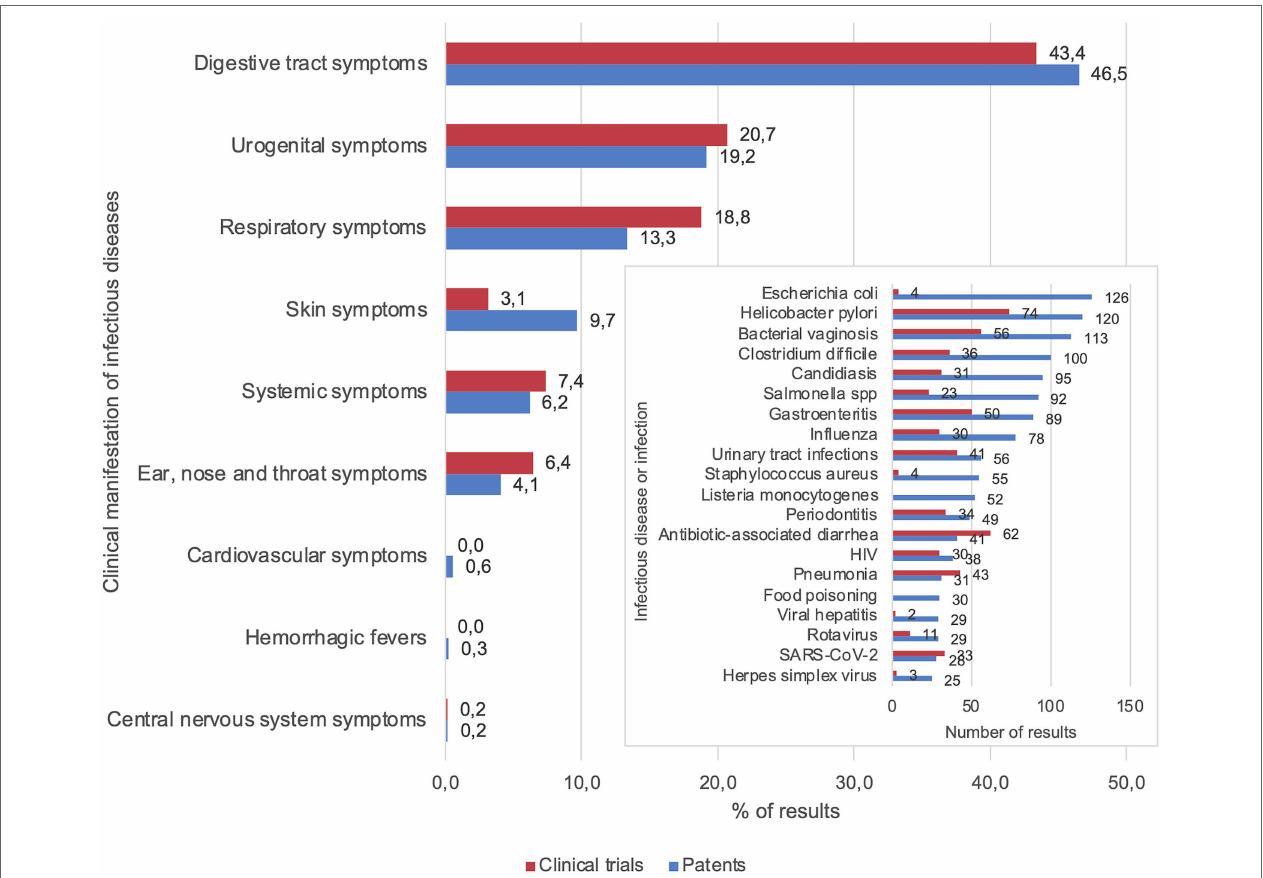
FIGURE 2 | Focal points of patents and clinical trials were digestive tract, urogenital, and respiratory symptoms. Percentages of patent and clinical trial results for each category of infectious diseases based on clinical manifestation. The 20 infectious diseases that were mentioned most frequently in patents are displayed in the insert graph (see Supplementary Figure 1 for complete